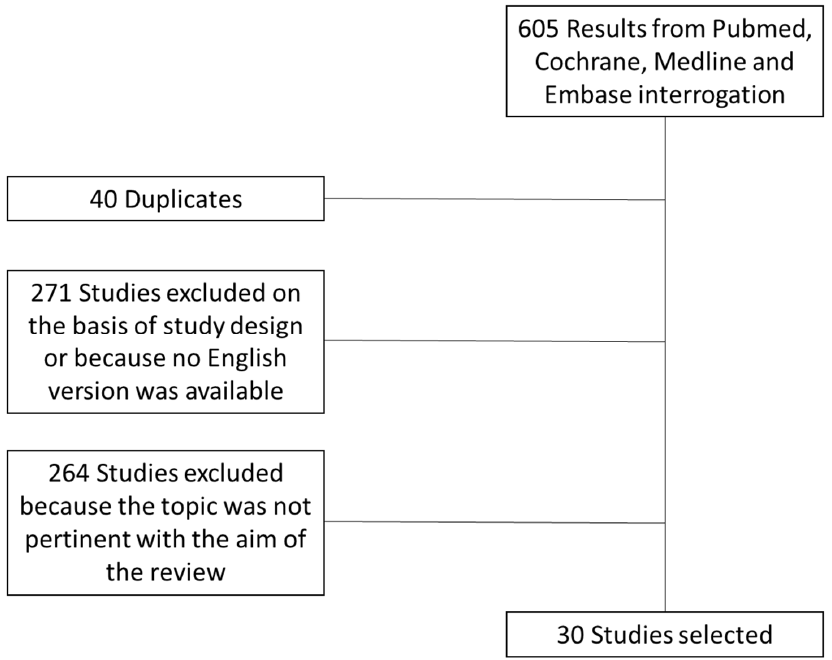
Figure 1. Flowchart of the study selection process. We reported the selection process of the studies included in this review.